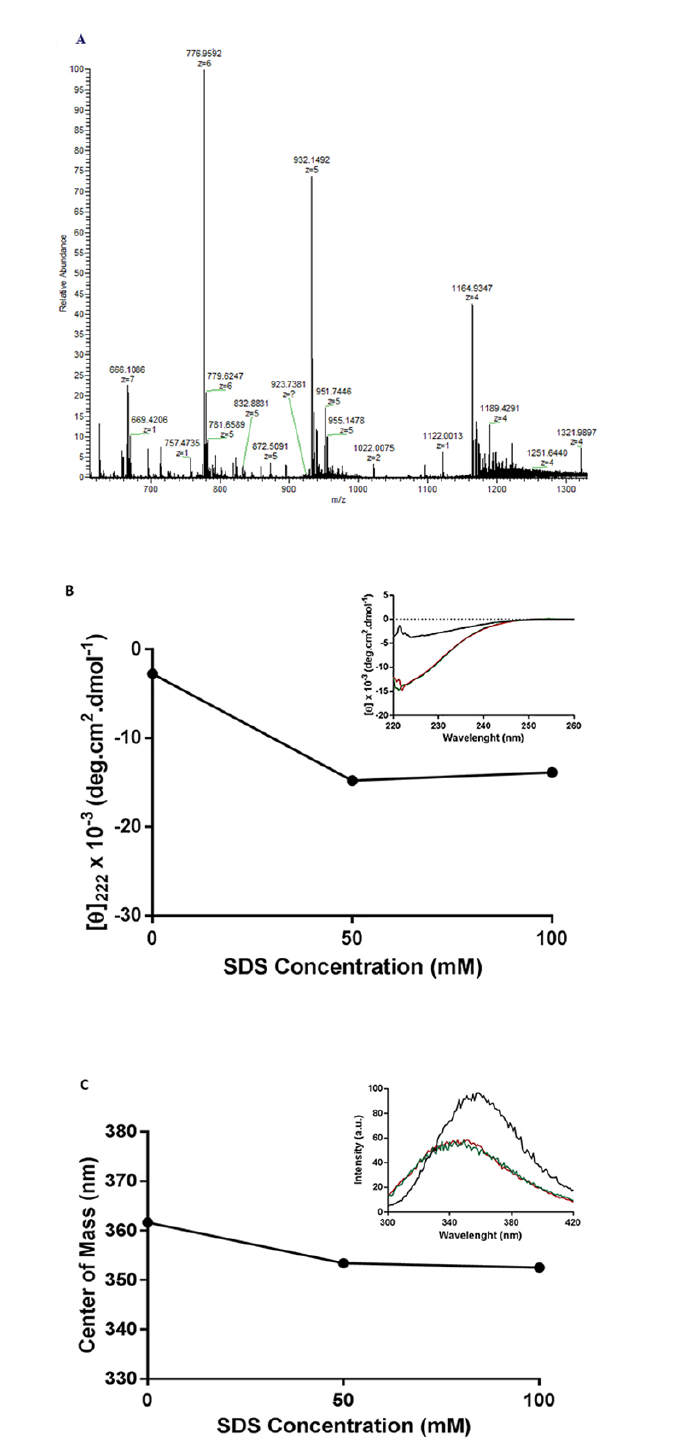
Figure 6. HRMS and secondary structure assays of AgCecropB. (A) Mass spectrum chromatogram of purified recombinant cecropin B. On the X axis, the detected fragments and their charge in the spectrum are identified; the Y axis shows the intensity of the fragments, based on their relative abundance. (B) Mean residue molar ellipticity at 222 nm of recombinant peptide AgCecropB in the presence of SDS. In the X axis the SDS molar concentration is expressed and in the Y axis is plotted the AgCecropB mean residue molar ellipticity value at 222 nm. Inset: circular dichroism spectrum (220-260 nm). X axis shows the wavelength and in the Y axis the mean residue molar ellipticity. Black line: control without SDS; red line: AgCecropB in the presence of SDS 50 mM; green line: AgCecropB in the presence of SDS 100 mM. (C) Center of mass analysis plot at 280 nm. In the X axis the SDS molar concentration is expressed and in the Y axis is plotted the uptake wavelength of AgCecropB center of mass. Inset: tryptophan intrinsic fluorescence assay plot measured at 280 nm; in the X axis is showed the absorption wavelength and in the Y axis the fluorescence intensity. Black line: control without SDS; red line: AgCecropB in the presence of SDS 50 mM; green line: AgCecropB in the presence of SDS 100